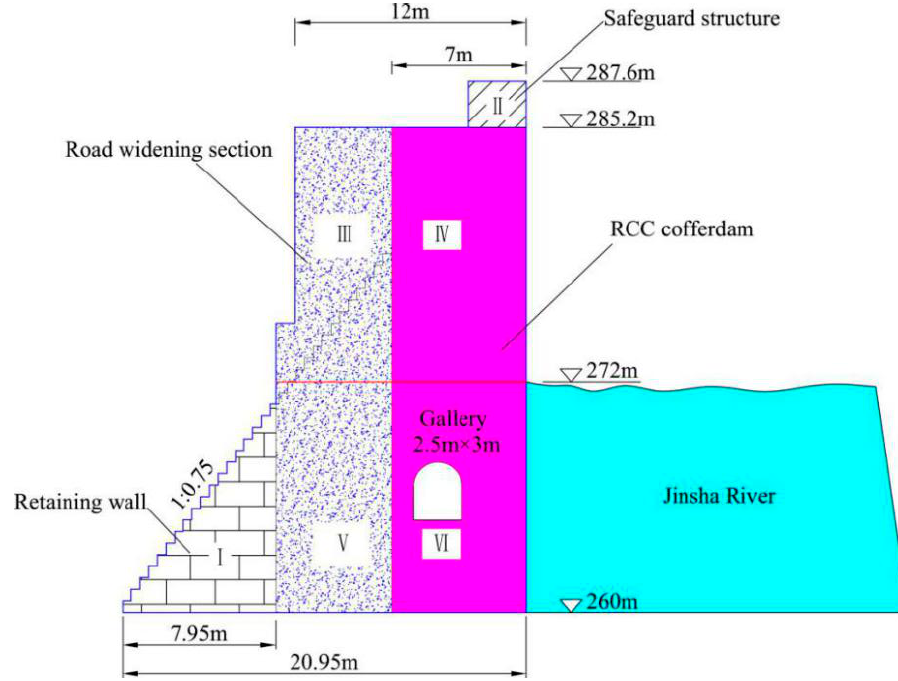
Figure 3. A-A profile of the transverse cofferdam.